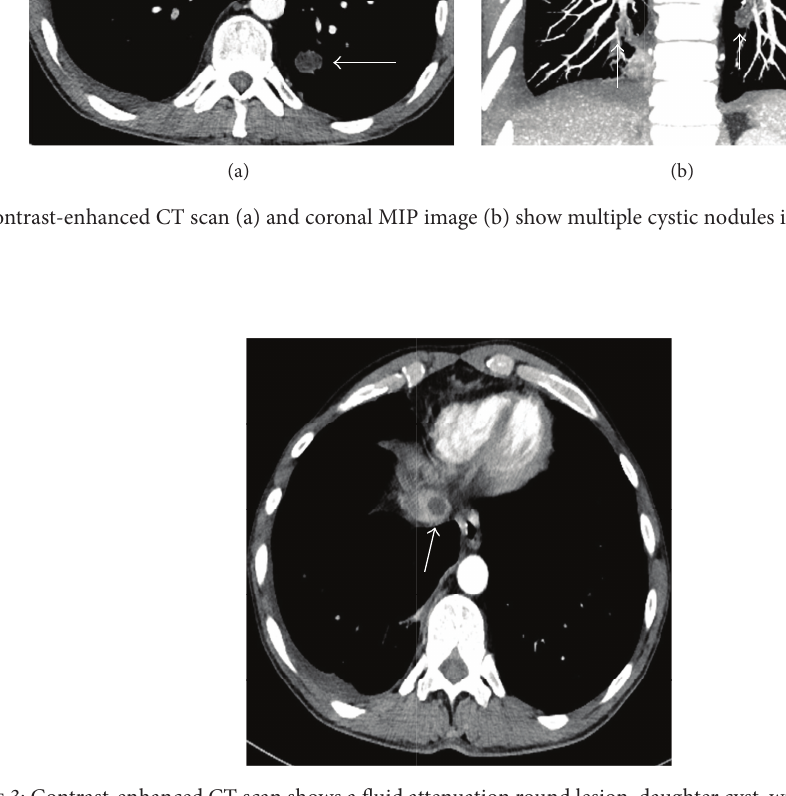
Figure 3: Contrast-enhanced CT scan shows a fluid attenuation round lesion, daughter cyst, within the IVC